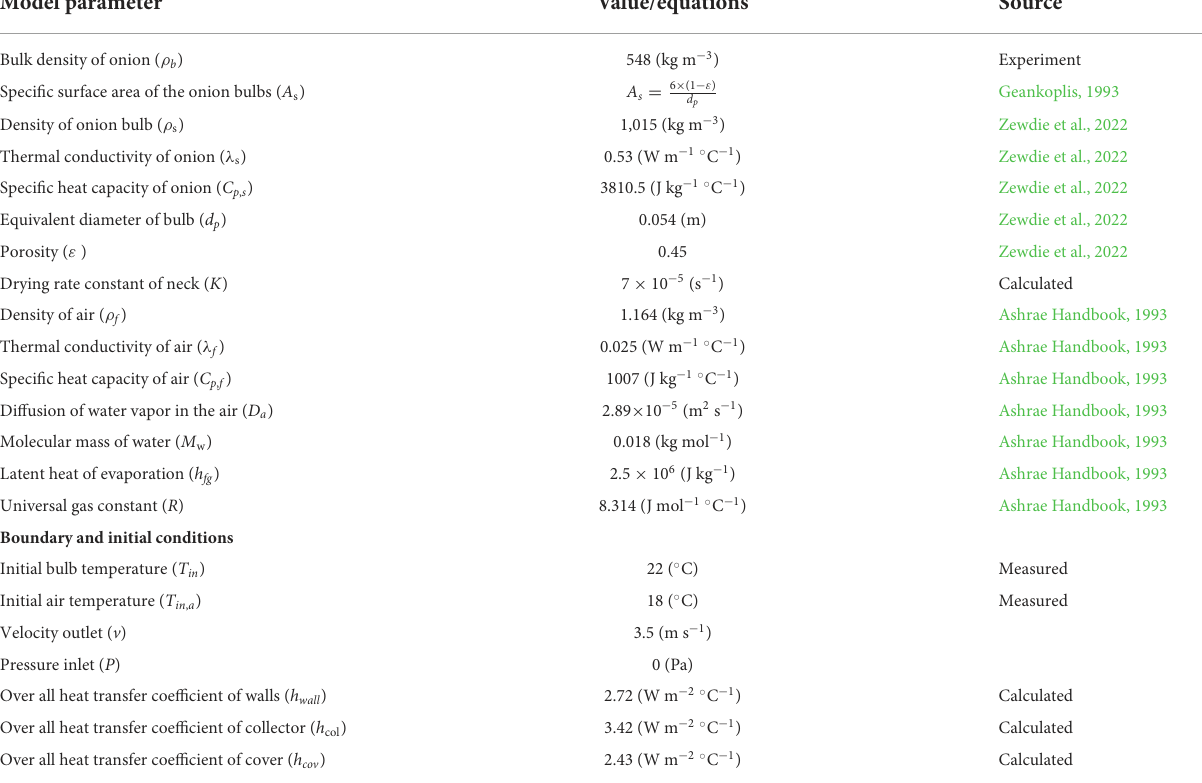
TABLE 2 Model parameters; boundary and initial